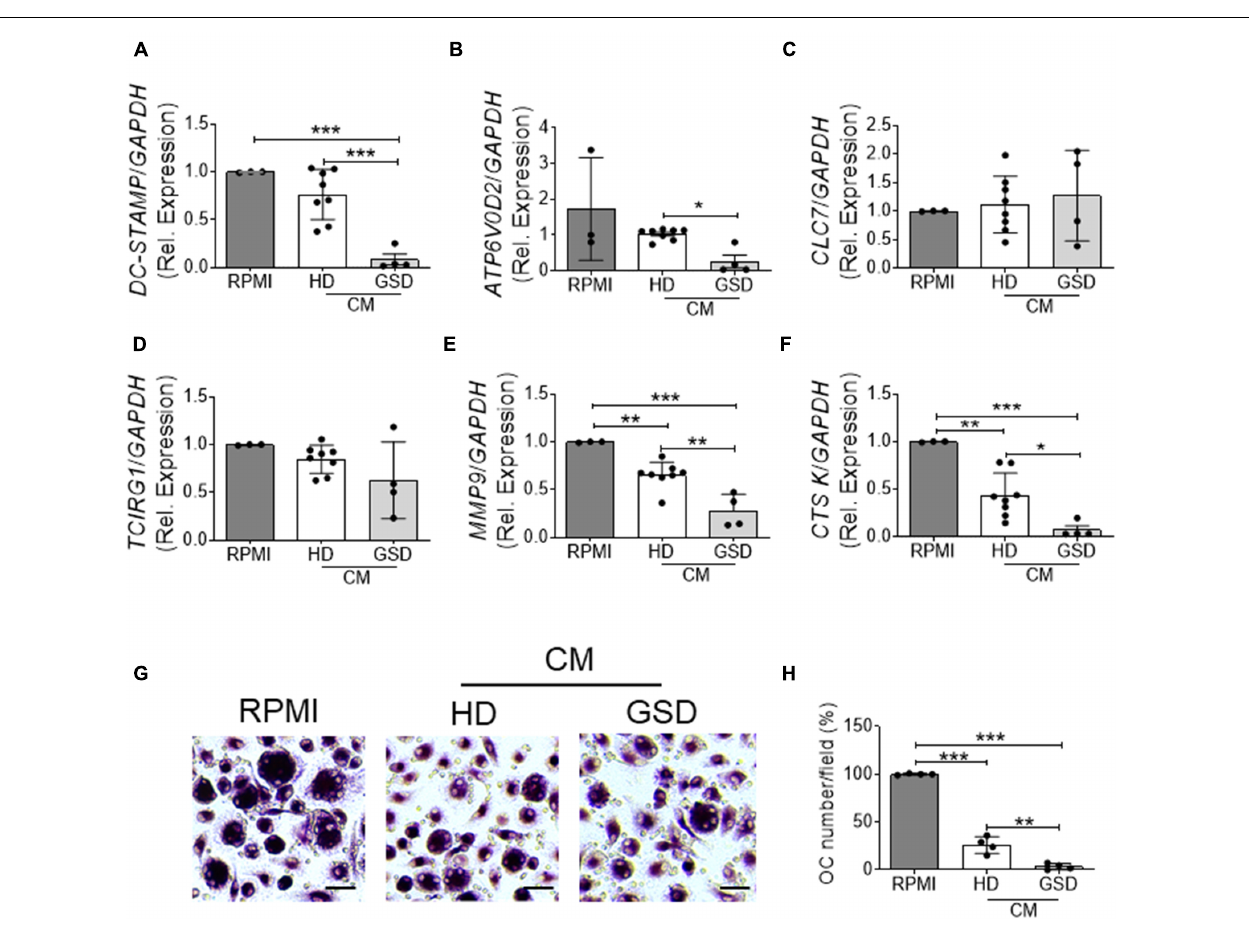
Frontiers in Cell and Developmental Biology |